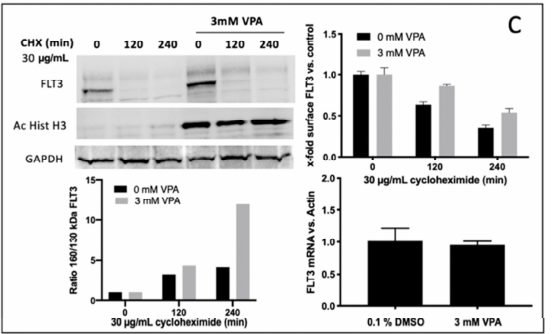
Figure 5. Impact of VPA on FLT3-ITD expression and downstream signaling in Ba/F3-ITD G613E cells. ( A , B ) concentration-dependent ( A ) and time-dependent ( B ) expression of surface FLT3-ITD and semi-quantitative analysis of 150 kDa versus 130 kDa isoform of FLT3-ITD. ( A ) Cells were treated for 24 h at the indicated VPA concentrations with subsequent analysis of FLT3-ITD expression by immunoblotting ( A , left) and flow cytometry ( A , upper right), respectively. ( B ), cells were treated with 3 mM VPA for 6 h and 24 h, respectively, prior to analysis of FLT3-ITD surface expression by flow cytometry ( B , right). Immunoblotting was performed for analysis of the downstream signaling pathways. Acetylhistone H3 expression served as a positive control for the VPA effect. For the loading control, the levels of GAPDH were detected. ( A , left and B , left). Densitometric analyses were performed by ImageJ Software. C, Ba/F3 FLT3-ITD G613E cells were pre-incubated with or without 3 mM VPA for 24 h, afterwards 30 µ g/mL cycloheximide (CHX) was added for the indicated time intervals. The protein lysates were subjected to immunoblotting ( C , upper left) and the ratio of 150 kDa versus 130 kDa isoform of FLT3-ITD that was dependent on VPA and CHX treatment was calculated by ImageJ Software ( C , lower left). FLT3-ITD surface expression was measured by flow cytometry ( C , upper right). The expression of FLT3-ITD mRNA levels after 24 h incubation of Ba/F3 FLT3-ITD G613E cells with 0.1% ( v / v ) DMSO or 3 mM VPA FLT3-ITD were quantified by qPCR ( C , lower right). The graphs are shown as the mean ± SD from three independent